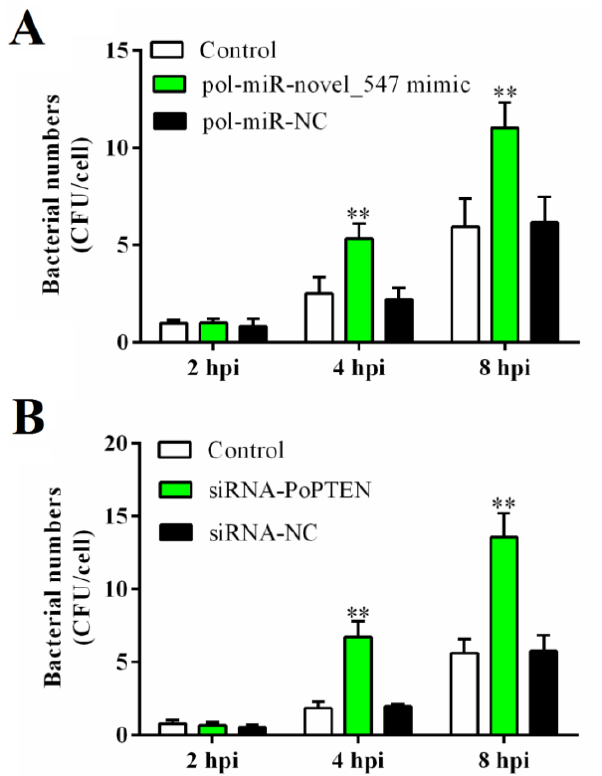
Figure 3. In vitro effects of pol-miR-novel_547 and PoPTEN on bacterial infection in flounder cells. ( A ) FG-9307 cells were transfected with or without (control) pol-miR-novel_547 mimic or pol-miR-NC and then infected with Edwardsiella tarda . Intracellular bacterial number was determined at different hours post infection (hpi) and shown as CFU (colony forming unit). ( B ) FG-9307 cells were transfected with or without (control) siRNA-PoPTEN or siRNA-NC and then infected with E. tarda . Intracellular bacterial number was determined as above. In both panels, values are the means of triplicate experiments and shown as means ± SEM. ** p < 0.01.